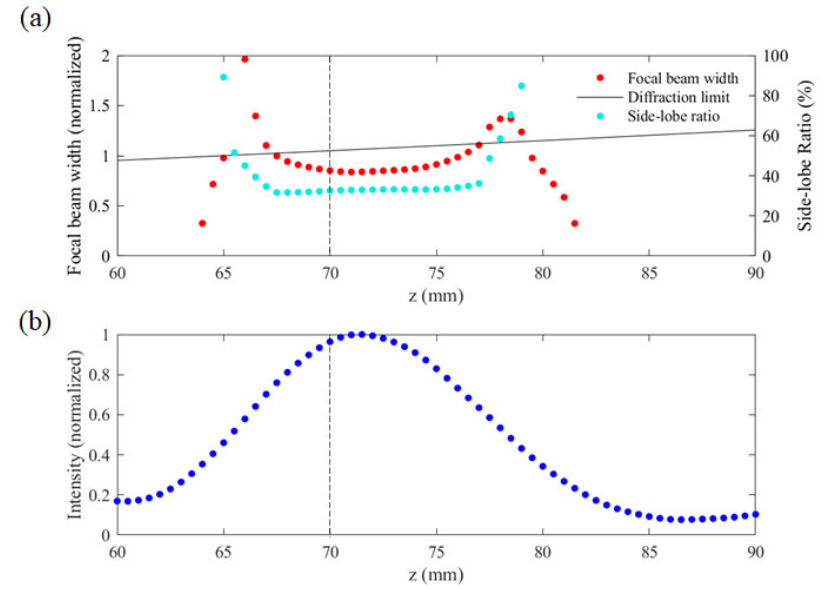
Figure 5. ( a ) The focal beam width along the z direction. The beam width values (red points) are normalized to the incident wavelength of 3 mm. The black solid line represents the diffraction limit while cyan points represent the side-lobe ratio; ( b ) The intensity profile of the focused THz beam at x = 0 mm, where the intensity values are normalized to the maximun intensity. The dashed line in ( a , b ) indicates the designed focal length of 70 mm.